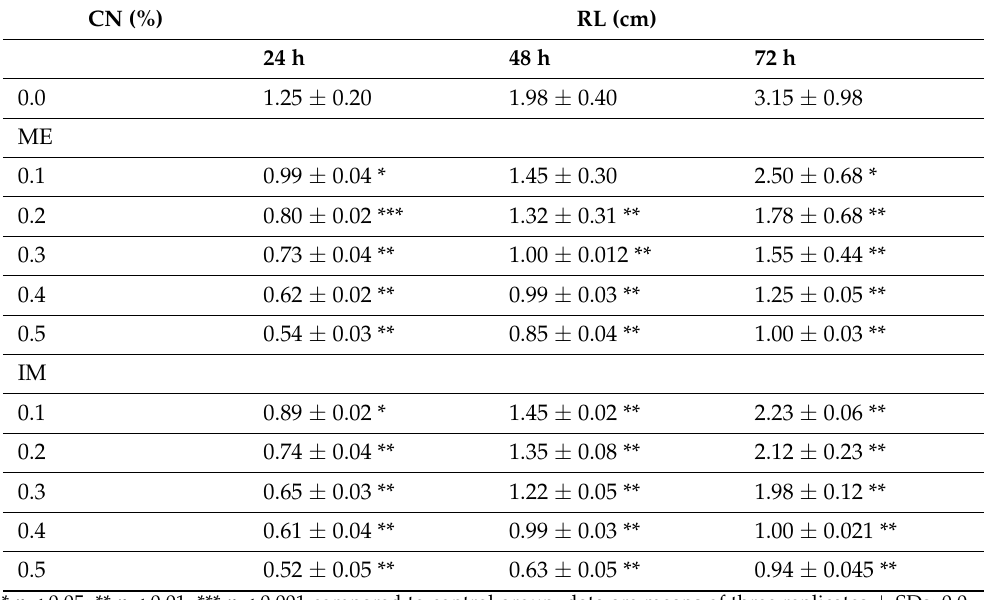
Table 2. Effect of ME and IM on radical length of P. sativum at different concentrations for 3 h.